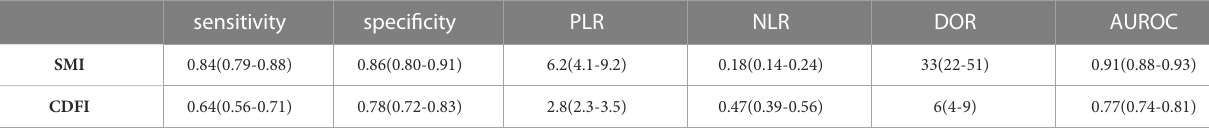
TABLE 3 Comparison of combined effects.